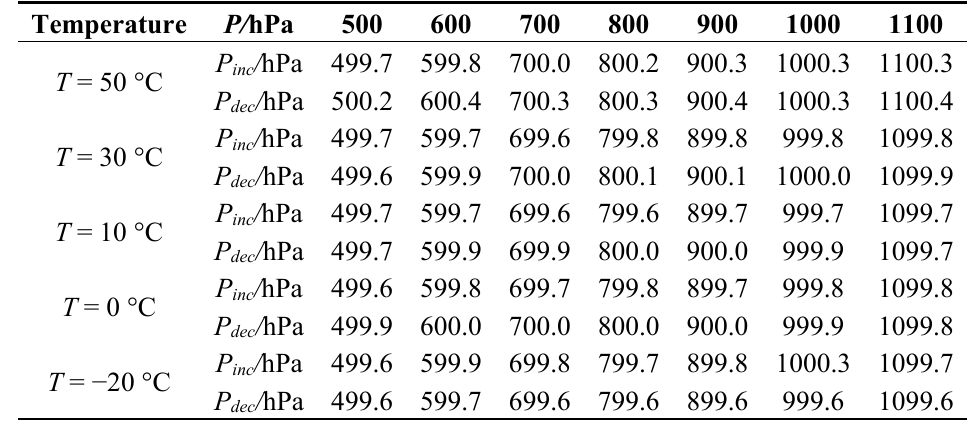
Figure 9. ( a ) The hysteresis error of the sensor array output signal at different temperatures. ( b ) The corresponding pressure hysteresis error at different temperatures. Table 4. The compensated and corrected pressures during the pressure increasing and pressure decreasing cycle at 50 °C, 30 °C, 10 °C, 0 °C, and − 20